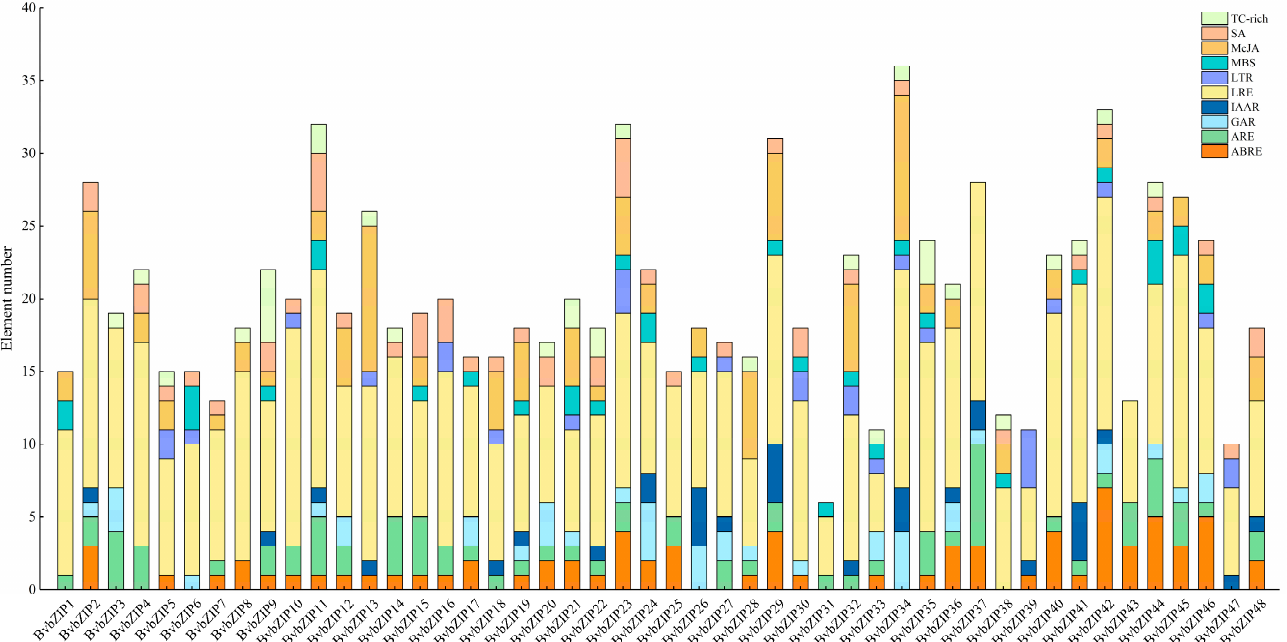
Figure 6. Functional element analysis of BvbZIP gene promoters. The vertical axis indicates the total number of functional components, the size of the box in the stack diagram indicates the number of specific functional components, and different colors indicate different types of functional components.